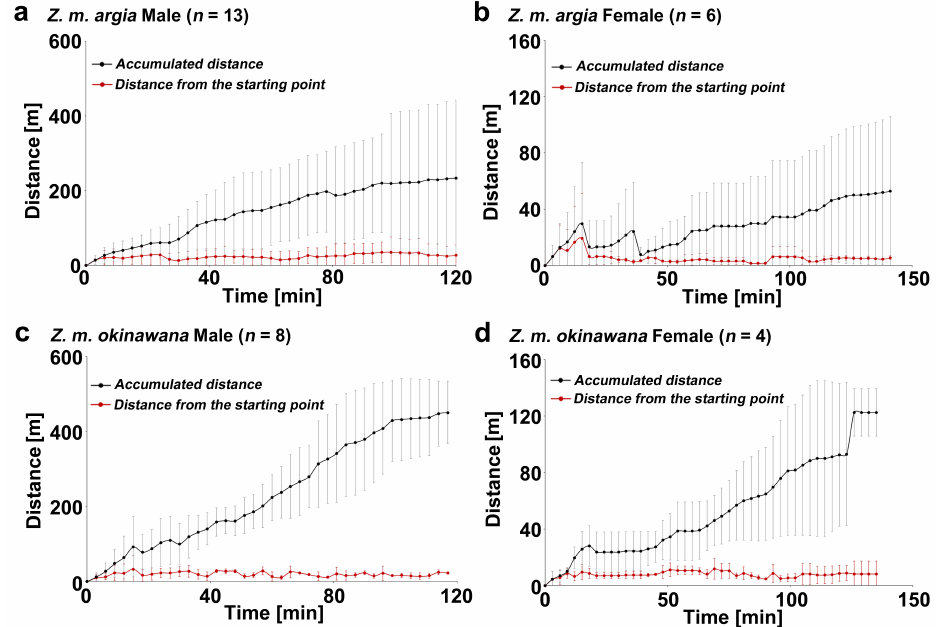
Figure 1. Dispersal distances of Z. maha males and females. Shown are the mean ± SD (standard deviation). The accumulated distance and the distance from the starting point were obtained using the number of individuals shown in each panel. A dot in late times does not necessarily represent the number of individuals shown in a panel because the tracking time varied among individuals. However, a dot represents at least two individuals. ( a ) Z. m. argia males. ( b ) Z. m. argia females. ( c ) Z. m. okinawana males. ( d ) Z. m. okinawana females.